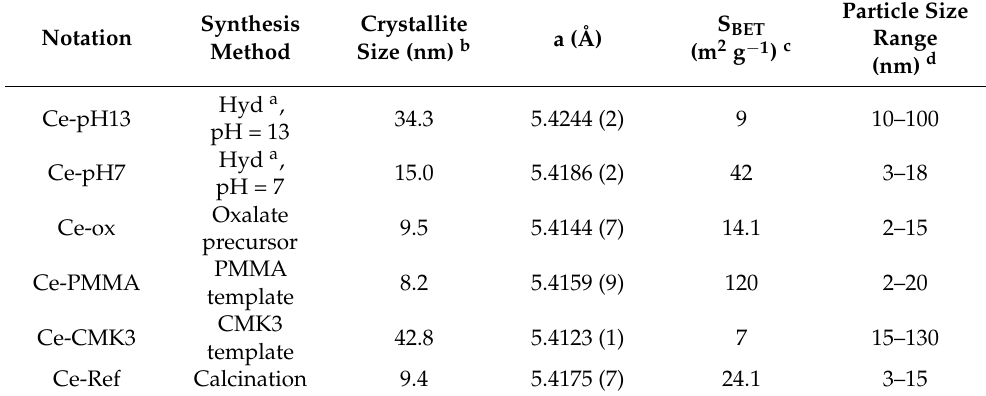
Table 1. Cell parameters, crystallite sizes and S BET values for the ceria samples.